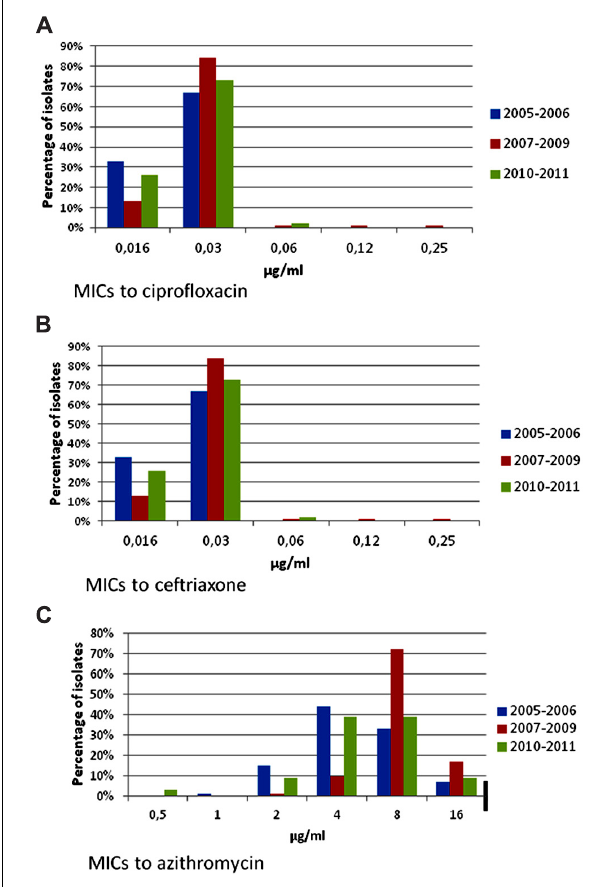
FIGURE 3 | Minimum inhibitory concentrations to ciprofloxacin, ceftriaxone, and azithromycin in Shigella isolates from children with gastroenteritis at a state referral hospital inYucatan, Mexico, 2005–2011. Thick black lines indicate breakpoints for resistance. Number of isolates for each period was as follows: 2005–2006, n = 73; 2007–2009, n = 79 and 2010–2011, n = 66. (A) Ciprofloxacin MICs. Isolates were fully susceptible to ciprofloxacin throughout the study.Two isolates had ciprofloxacin MICs ≥ 0.12 μ g/ml, only one of which was resistant to nalidixic acid. CLSI breakpoints for susceptibility and resistance are 1 and 4 μ g/ml, respectively. (B) Ceftriaxone MICs. All isolates remained fully susceptible to ceftriaxone with no changes over the study period. CLSI breakpoints for susceptibility and resistance are 1 and 4 μ g/ml, respectively. (C) Azithromycin MICs. Suggested breakpoints are the same as those proposed for Salmonella . Although isolates were apparently susceptible to azithromycin throughout the study period, 7–17% of these had an MIC =